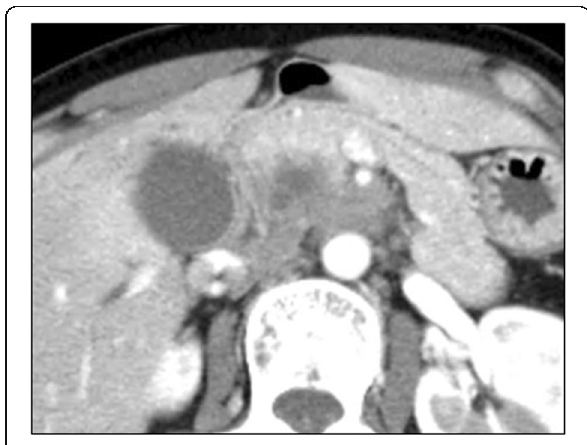
Fig. 1 Arterial phase of the MDCT at first visit shows a massive hypovascular tumor in the uncinate process that was in direct contact with the SMA (>180°), but without stenosis or obstruction. It was clinically diagnosed as an unresectable LAPC (defined by the criteria of JPS, 7th ed.)